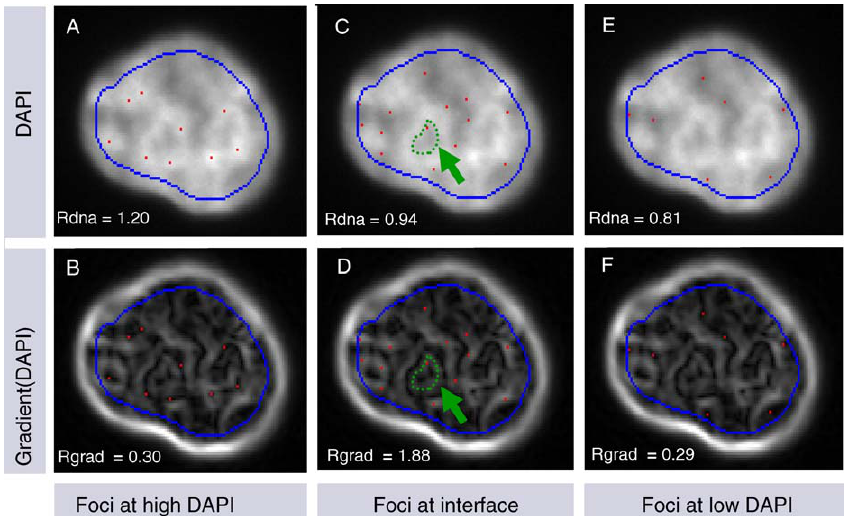
Figure 6. Illustration of Rdna and Rgrad Measurements Three hypothetical foci patterns over the same nucleus are illustrated with their corresponding Rdna and Rgrad values. Upper images (A,C,E) are overlays of the DAPI image with the center of hypothetical foci (in red). Lower images (B,D,F) are overlays of the foci location with the gradient image of DAPI. The gradient operator is often used in imaging as an edge detector. To illustrate this, the green arrow in (C) delineates the contour of the edge of a bright DAPI region. One can see in the corresponding gradient image in (D) that the same contour correlates to a bright gradient region. Rdna measures the ratio of the mean nuclear intensity at the foci locations over the mean intensity of the full nucleus. Rgrad measures the same ratio on the gradient image. Because the boundary of the nuclear image creates a strong gradient intensity, a conservative contour is used for nuclear segmentation (shown in blue) to avoid an edge effect when calculating Rdna and Rgrad . In (A) and (B), foci are placed in areas of surrounding high nuclear density. The surrounding high density keeps the foci distal from areas of density change, thus we see the foci lie in low-intensity regions in the corresponding gradient image. This results in Rdna above 1 and Rgrad below 1. By manually placing foci at different locations with respect to DNA density regions, we show that Rdna is high when foci are located in bright regions of the nucleus (A) and (B); Rgrad is high when foci are located at the interface of bright and dim regions of the nucleus (C) and (D); and Rdna is low when foci are located in dim regions of the nucleus (E) and (F).